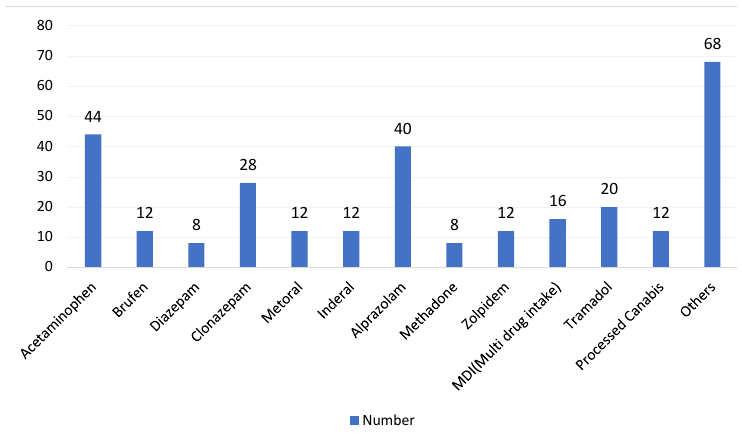
Figure 2 . Distribution of toxicity reason based on Kolmogorov-Smirnov test.